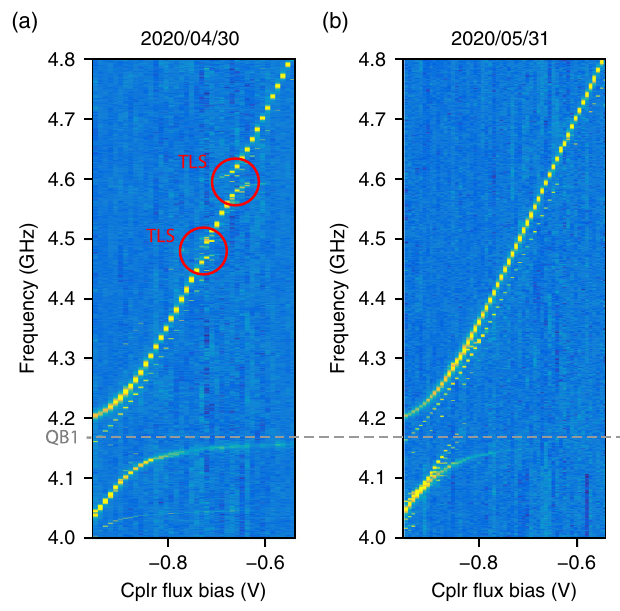
FIG. 10. (a) Experimental data of coupler spectroscopy meas- urement when TLSs appear in the operating frequency range of CPLR. (b) We displace the TLSs from the operating frequency range of the coupler by thermal cycling to room